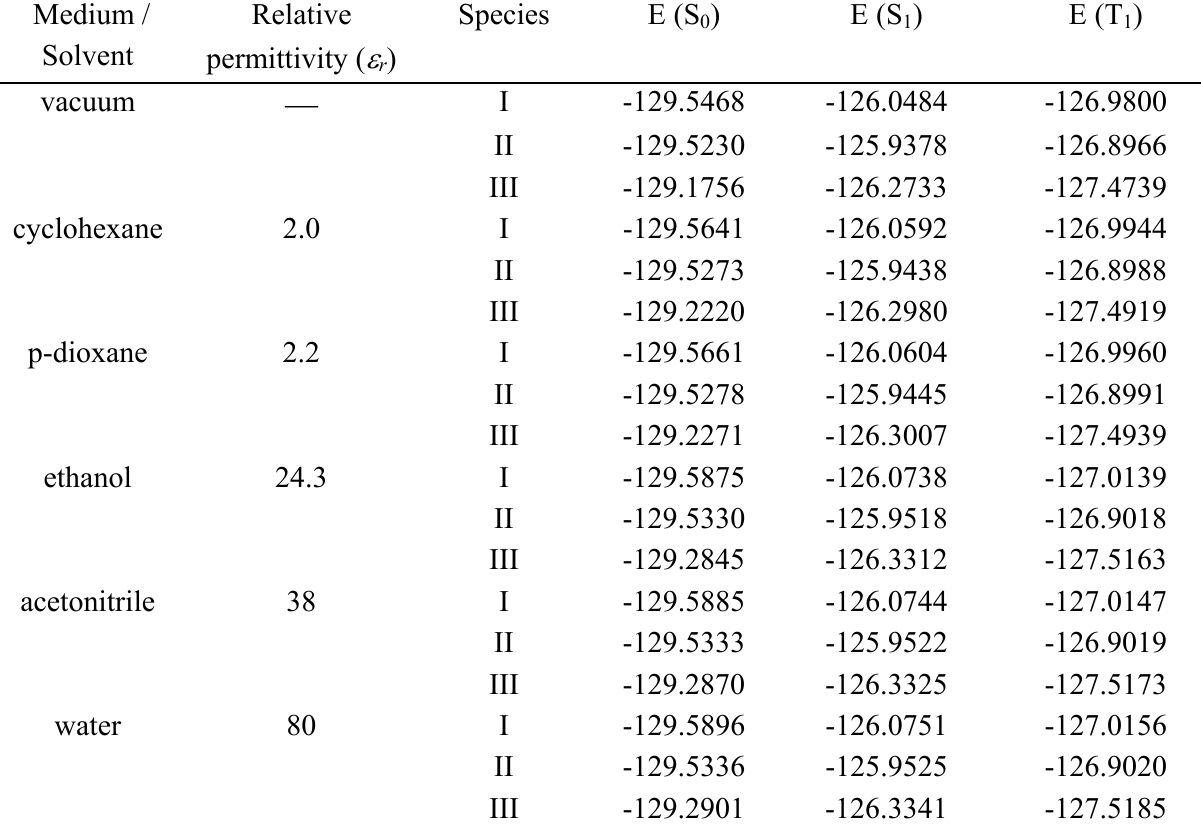
Table 4. Calculated S HBI in isolated and solvated conditions (Onsager’s cavity radius, a = 5.47 Å).